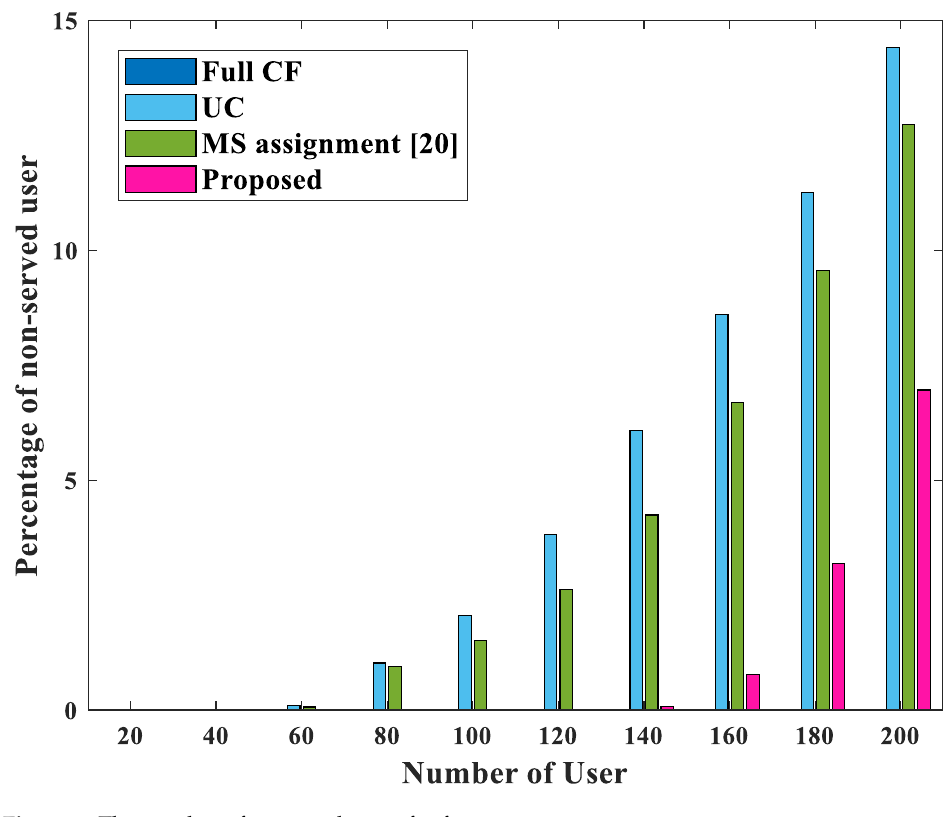
Figure 8. The number of unserved users for four